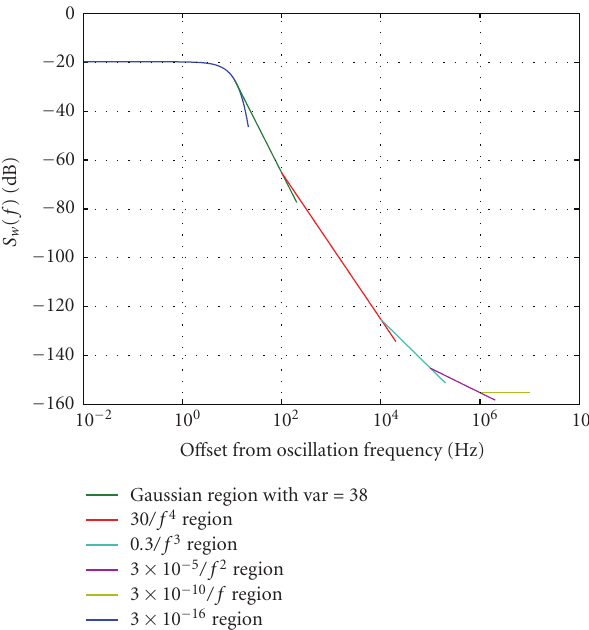
Figure 1: Enhanced oscillator spectral model for k 4 = 30, k 3 = 0 . 3, k 2 = 3 · 10 − 5 , k 1 = 3 · 10 − 10 , and k 0 = 3 · 10 − 16 . The near-to- the-carrier regime is Gaussian with Ω = 38, followed by a sequence of power-law regions with frequencies of transition f 4 = 11 . 3 Hz, and f 3 = 100Hz, f 2 = 10 4 Hz, f 1 = 10 5 Hz while the bandwidth of the system is assumed to be f B = 10 7 Hz.